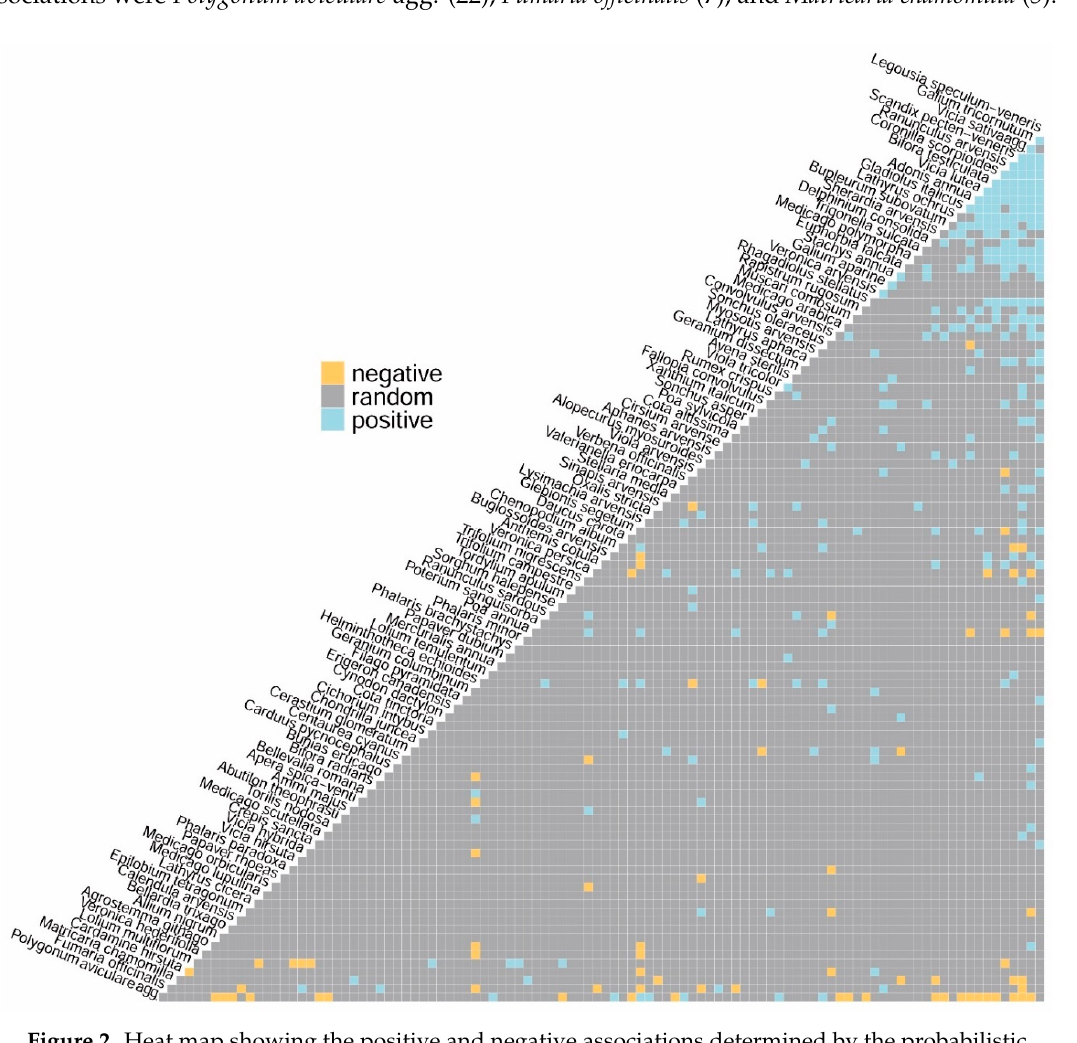
Figure 2. Heat map showing the positive and negative associations determined by the probabilistic co-occurrence model for the arable plant species from our dataset.